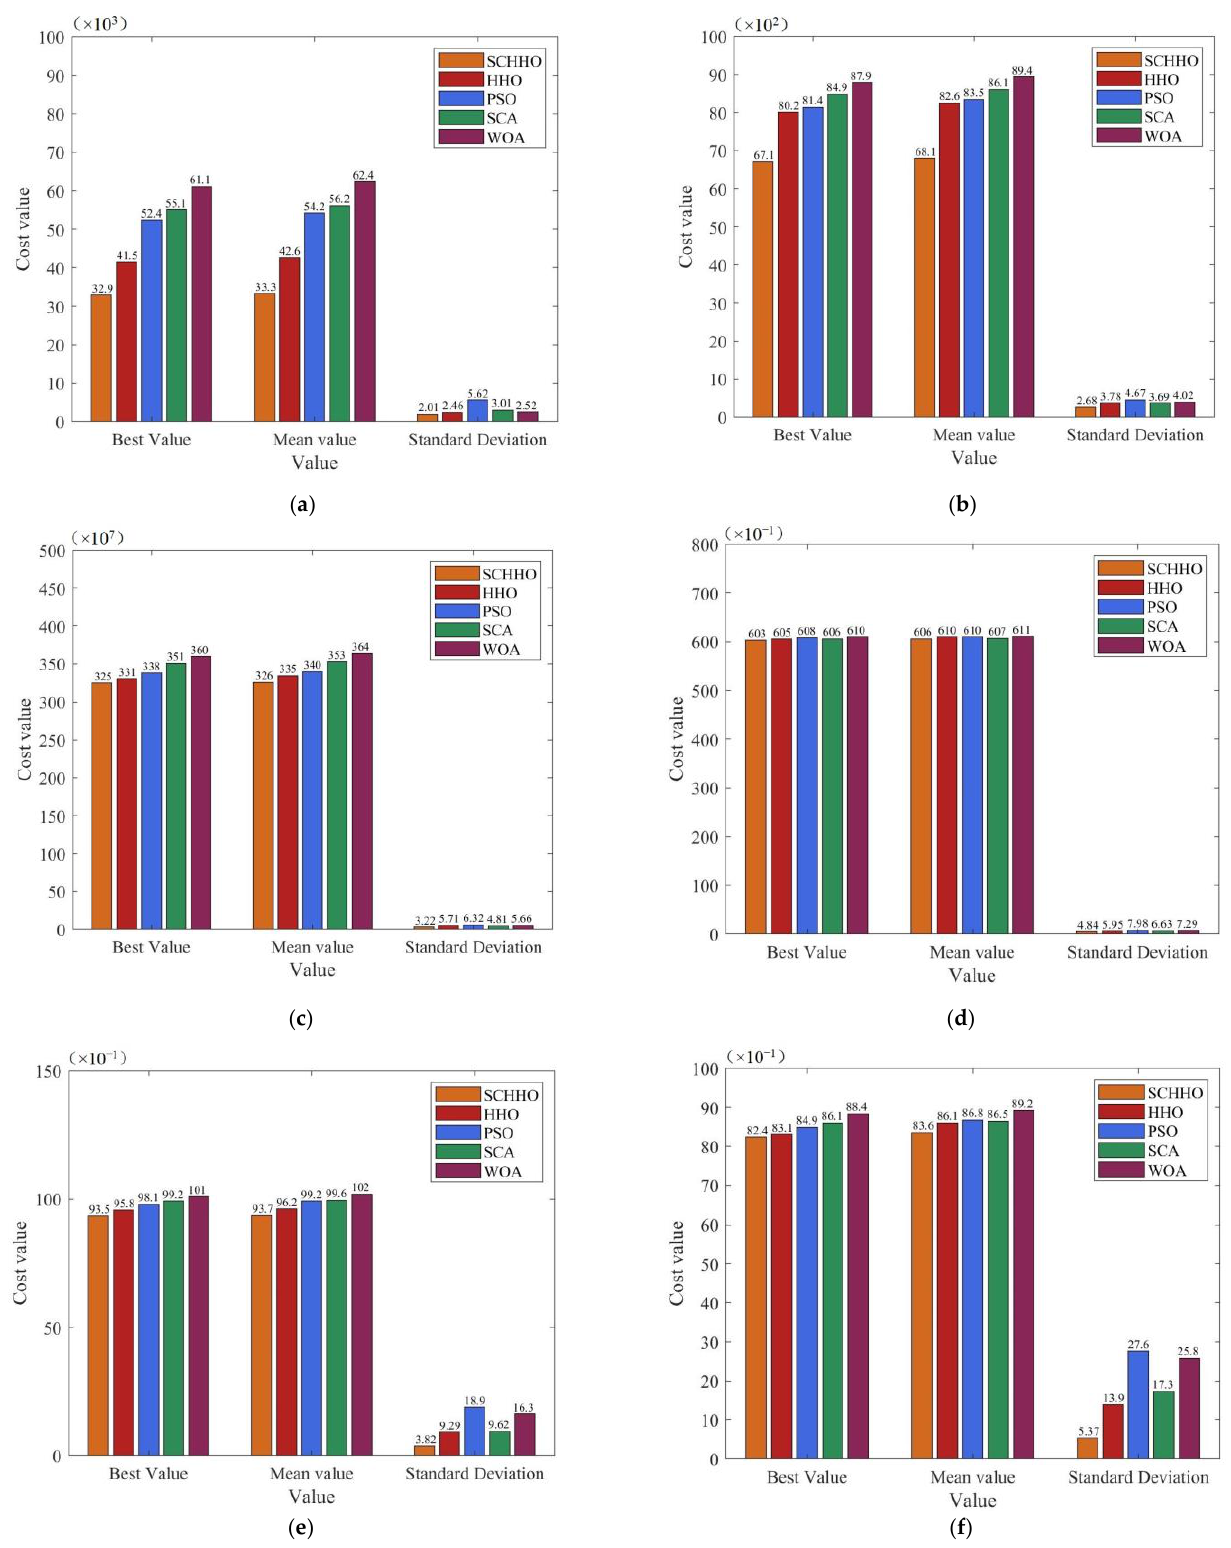
Figure 4. Experimental results on benchmark functions when n = 50. ( a ) Sphere. ( b ) Schwefel1.2. ( c ) Rosenbrock. ( d ) Rastrigin. ( e ) Ackley. ( f ) Griewank.